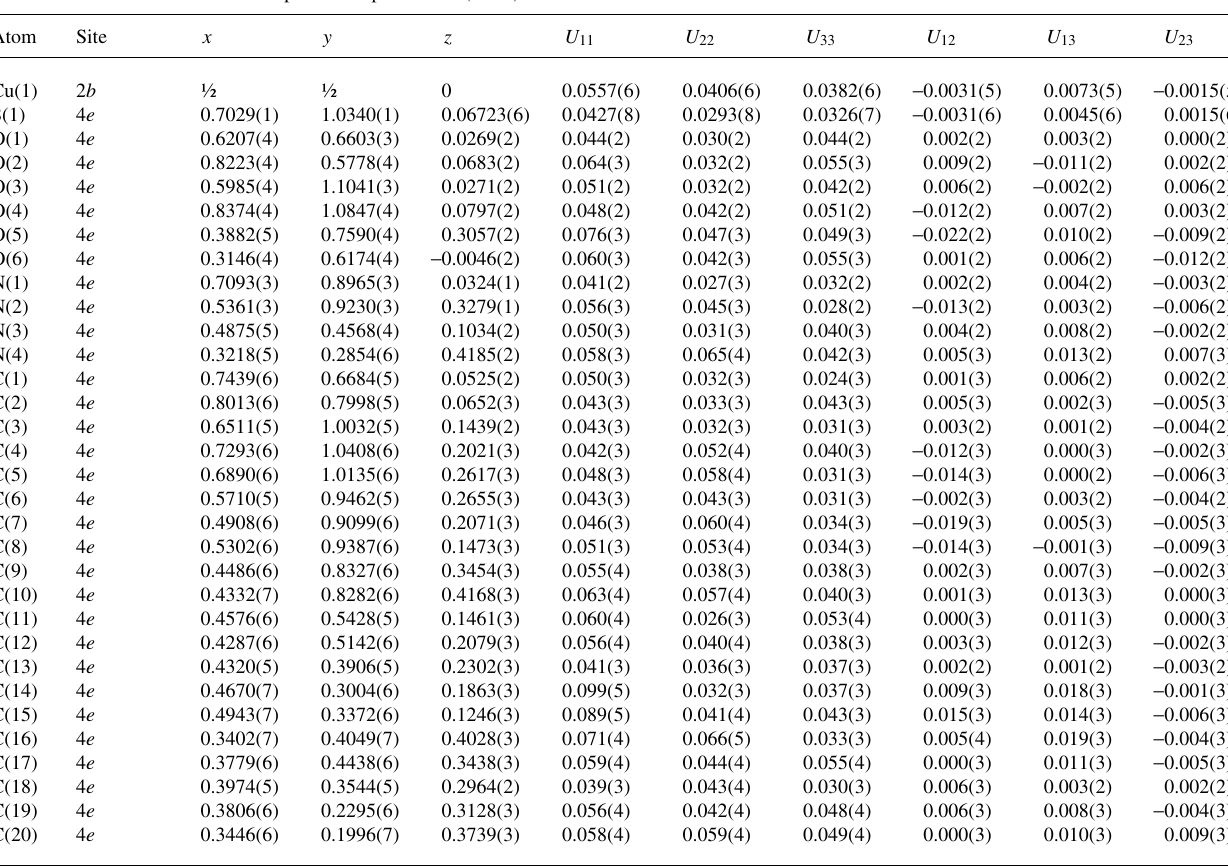
Table 3. Atomic coordinates and displacement parameters (in Å 2 )